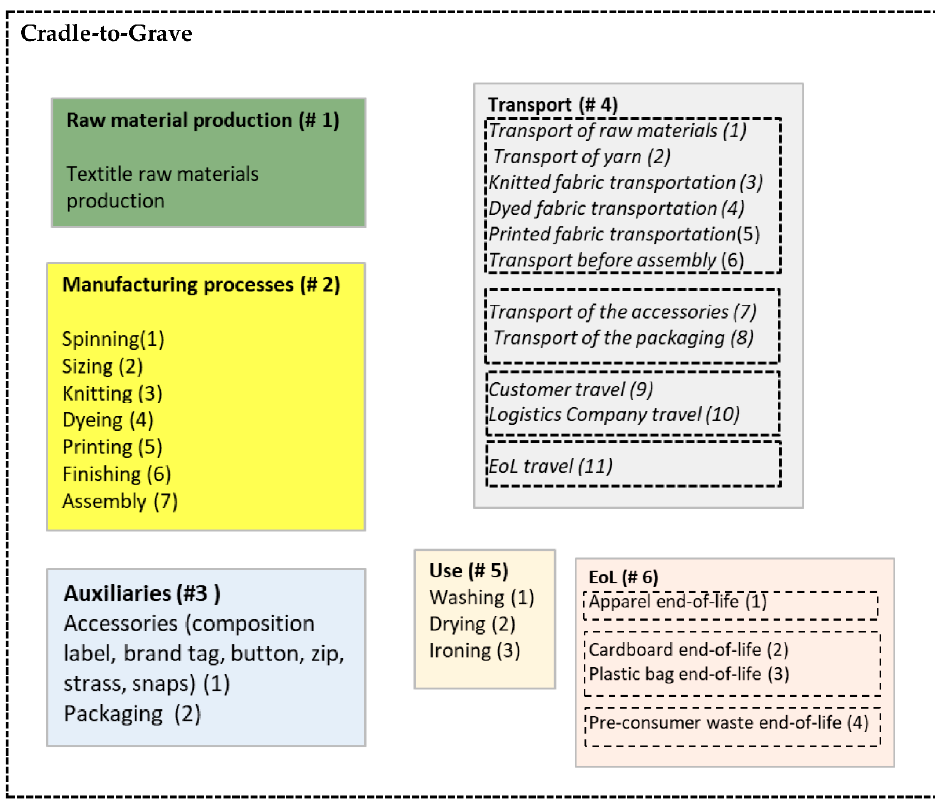
Figure 4. Possible boundaries for LCA studies related to apparel. Cradle-to-gate #1, #2, #3 and (w/transport #4 1–8); cradle-to-use #1, #2, #3, #5 and (w/transport #4 1–11).